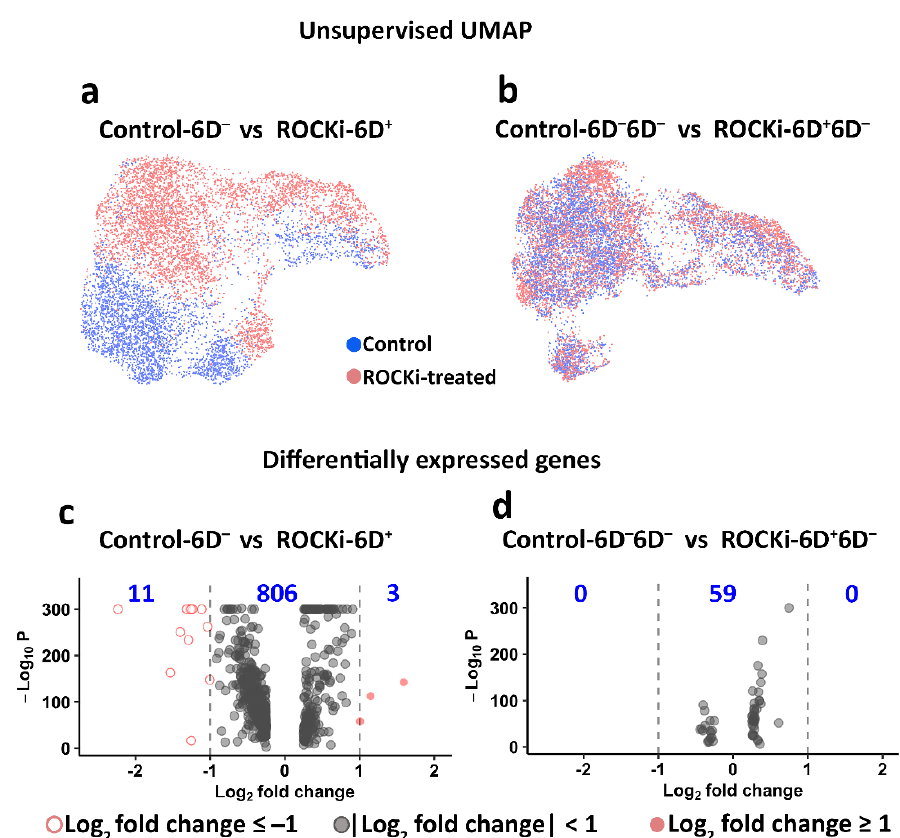
Figure 5. Single-cell transcriptomic analysis. Single-cell transcriptomic analysis was performed using the data generated from scRNAseq. Uniform manifold approximation and projection (UMAP) plots show distinct clusters between non-treated (Control-6D − ) and ROCKi-treated (ROCKi-6D + ) cells ( a ), whereas cells from the ROCKi-withdrawn (ROCKi-6D + 6D − ) and non-treated (Control- 6D − 6D − ) groups clustered together ( b ). Differentially expressed genes between ROCKi-treated, ROCKi-treatment withdrawn, and non-treated cells show in the volcano plots ( c , d ). The numbers in blue indicate the number of